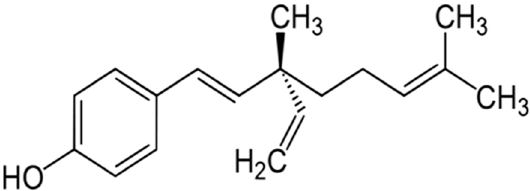
Figure 1. Chemical structure of bakuchiol.